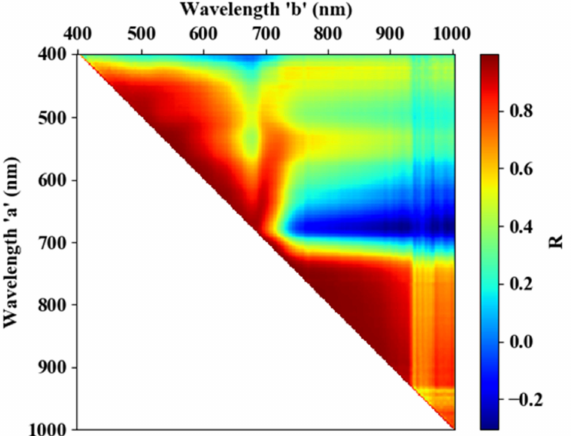
Figure 7. Correlation coefficient between every two